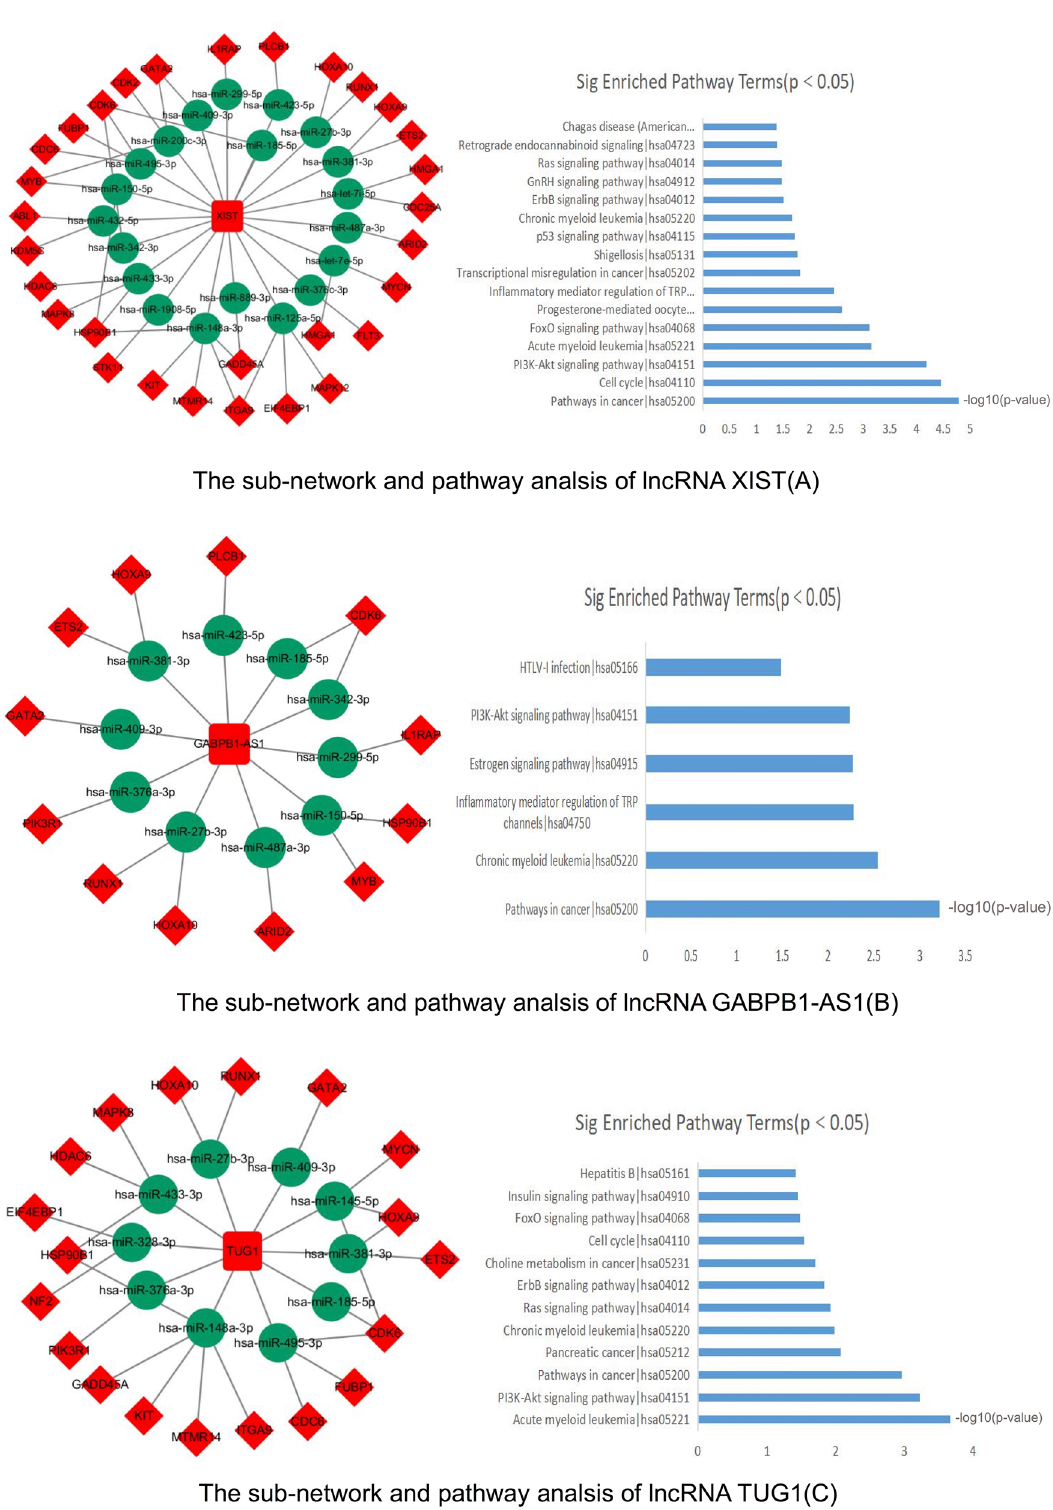
Figure 6. The sub-networks of three key lncRNAs and their KEGG pathway analysis by KOBAS. ( A ) The sub-network of lncRNA XIST and the significantly enriched pathway terms of its related mRNAs. ( B ) The sub- network of lncRNA GABPB1-AS1 and the significantly enriched pathway terms of its related mRNAs. ( C ) The sub-network of lncRNA TUG1 and the significantly enriched pathway terms of its related